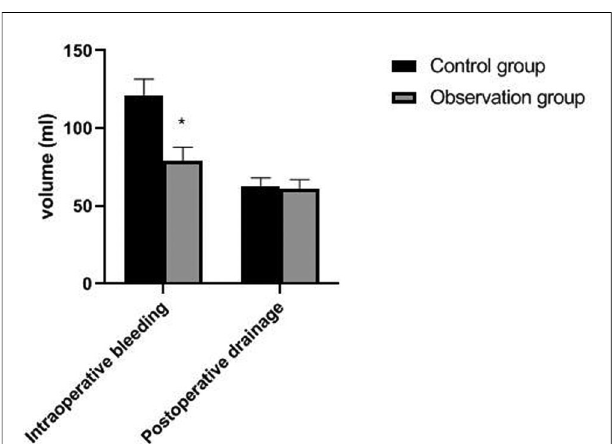
FIGURE 4 | Comparison of intraoperative bleedingv and postoperative drainage between the two groups. Note: compared with the control group, * p <0.05.